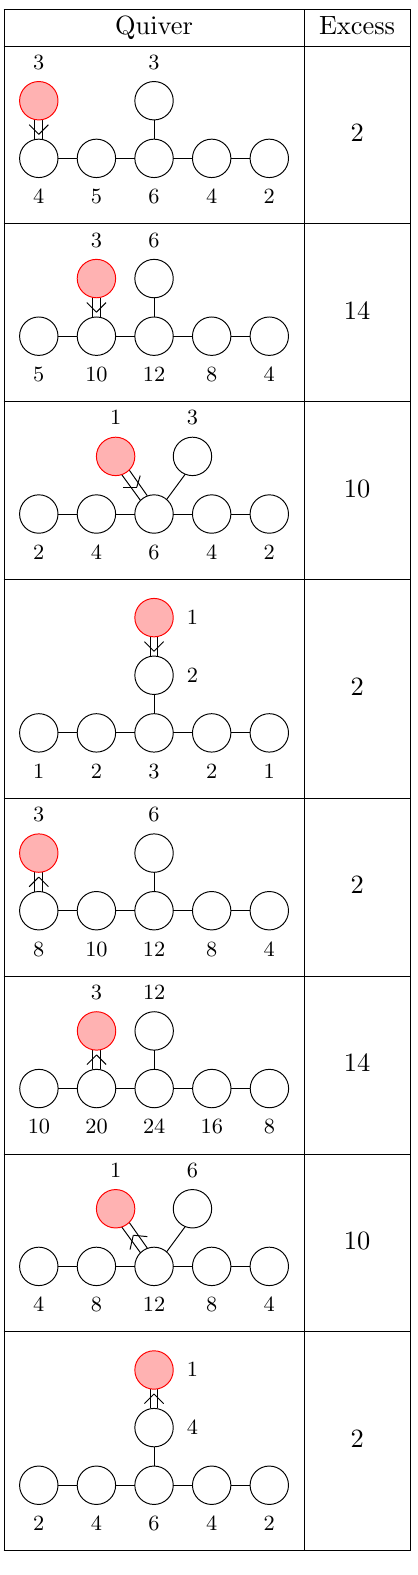
Table 18 . Exotic minimally unbalanced quivers of E 6 -type with a double laced